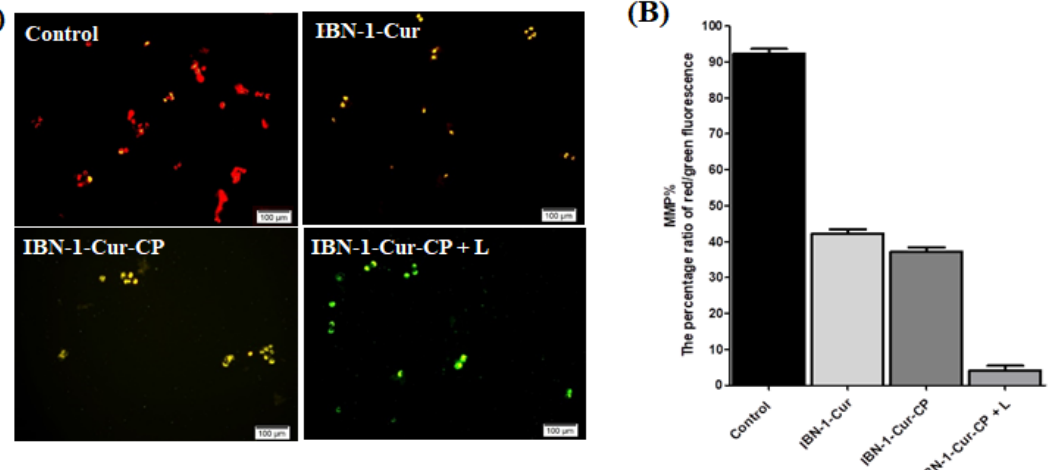
Figure 13. MMP assay on MES-SA/DX5 cells using the JC-1 staining method. ( A ) MMP depolarization was examined using a fluorescence microscope after cells were treated with IBN-1-Cur, IBN-1-Cur-CP (dark), and IBN-1-Cur-CP (light) (50 g/mL), a scale bar of 100 µ m. ( B ) Quantitative analysis of the ratio of red/green fluorescent percentage intensity using a microplate reader.